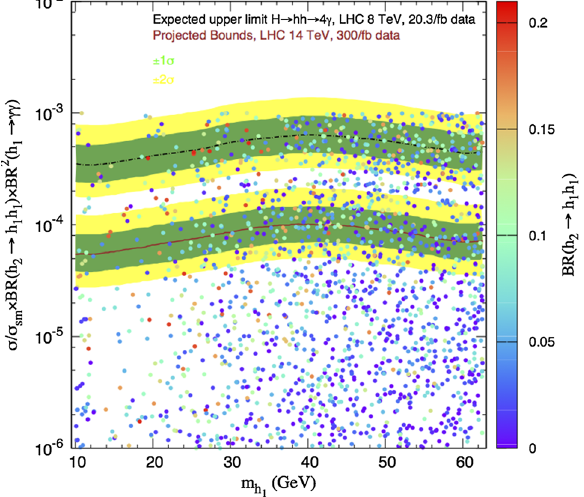
× Br ( h → h → 4 γ) as Fig. 9 Upper limit at 95% CL on σ( h 2 ) σ 2 1 h 1 sm a function of m h vs. Br ( h 2 → h 1 h 1 ) from ATLAS searches at 8 TeV 1 (upper band) and the projection for 14 TeV (lower band) taken from [65]. The green and yellow color indicate the allowed regions at 68% and 95%, respectively